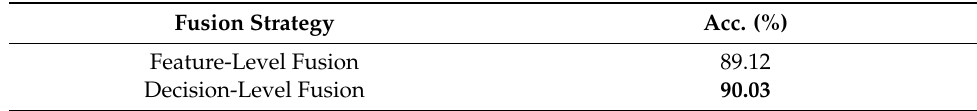
Table 3. Evaluation of Fusion Strategies on the RAF-DB dataset.